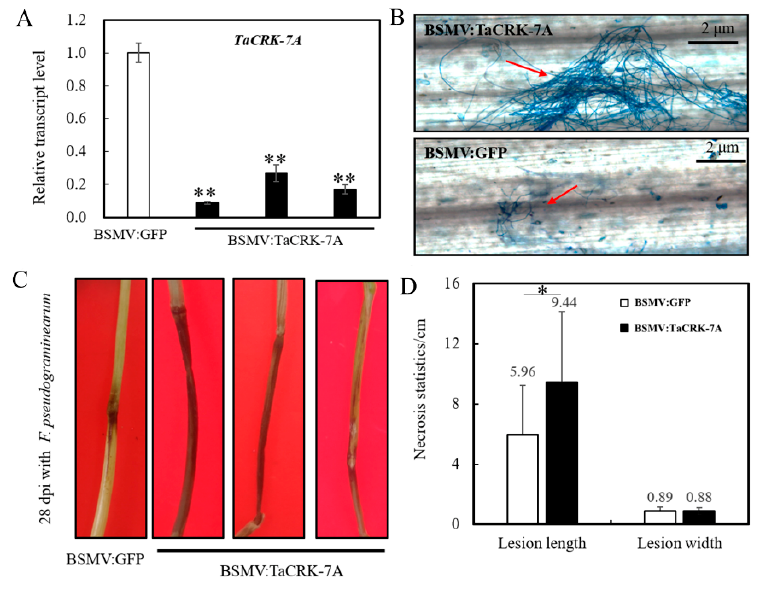
Figure 3. Knocking ‐ down of TaCRK ‐ 7A increases susceptibility of the wheat cv. CI12633 to F. Figure 3. Knocking-down of TaCRK-7A increases susceptibility of the wheat cv. CI12633 to F. pseudo- pseudograminearum . ( A ) TaCRK ‐ 7A transcript was markedly knocked down in graminearum . ( A ) TaCRK-7A transcript was markedly knocked down in BSMV:TaCRK7A-infected BSMV:TaCRK7A ‐ infected wheat CI12633 plants relative to BSMV:GFP ‐ transfected CI12633 (con ‐ wheat CI12633 plants relative to BSMV:GFP-transfected CI12633 (control) plants at 12 d after the trol) plants at 12 d after the virus transfection. The transcript level in BSMV:GFP ‐ transfected (con ‐ virus transfection. The transcript level in BSMV:GFP-transfected (control) plants was set to 1. TaActin trol) plants was set to 1. TaActin was used as internal control. ( B ) Microscopic observation of the F. was used as internal control. ( B ) Microscopic observation of the F. pseudograminearum hyphae on the pseudograminearum hyphae on the fungus ‐ infected sheaths of the BSMV:TaCRK ‐ 7A ‐ silenced and fungus-infected sheaths of the BSMV:TaCRK-7A-silenced and BSMV:GFP-infected CI12633 plants. BSMV:GFP ‐ infected CI12633 plants. ( C ) FCR symptoms on the BSMV:GFP (control) and TaCRK ‐ 7A ‐ silenced CI12633 sheaths at 28 dpi with F. pseudograminearum WHF220. ( D ) The average ( C ) FCR symptoms on the BSMV:GFP (control) and TaCRK-7A-silenced CI12633 sheaths at 28 dpi lesion length and width of the BSMV:GFP ‐ transfected and BSMV:TaCRK ‐ 7A ‐ silenced plants. ** p < with F. pseudograminearum WHF220. ( D ) The average lesion length and width of the BSMV:GFP- 0.01 and * p < 0.5 (Student’s t ‐ test) represent s tatistic ally significant differences derived from three transfected and BSMV:TaCRK-7A-silenced plants. ** p < 0.01 and * p < 0.5 (Student’s t -test) represent repeats. Bars represent standard error of the mean. statistically significant differences derived from three repeats. Bars represent standard error of the